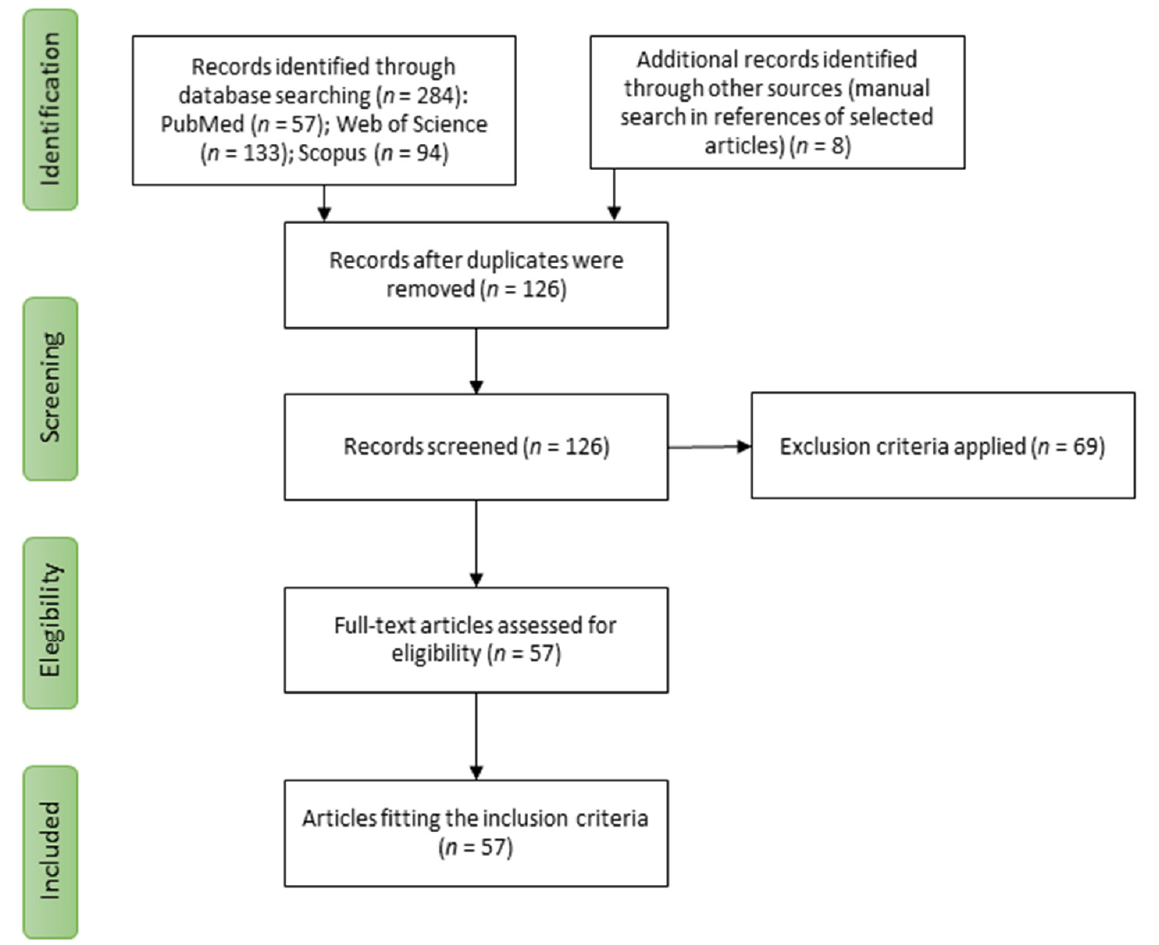
Figure 1. Study selection process for the systematic review.